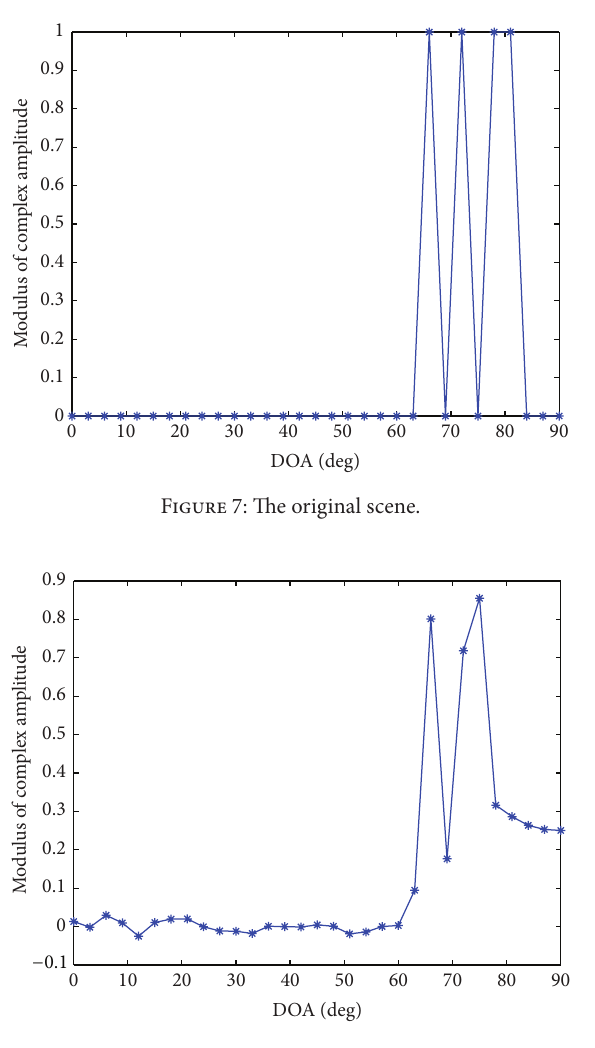
Figure 8: DOA estimation using the standard compressed sensing method.